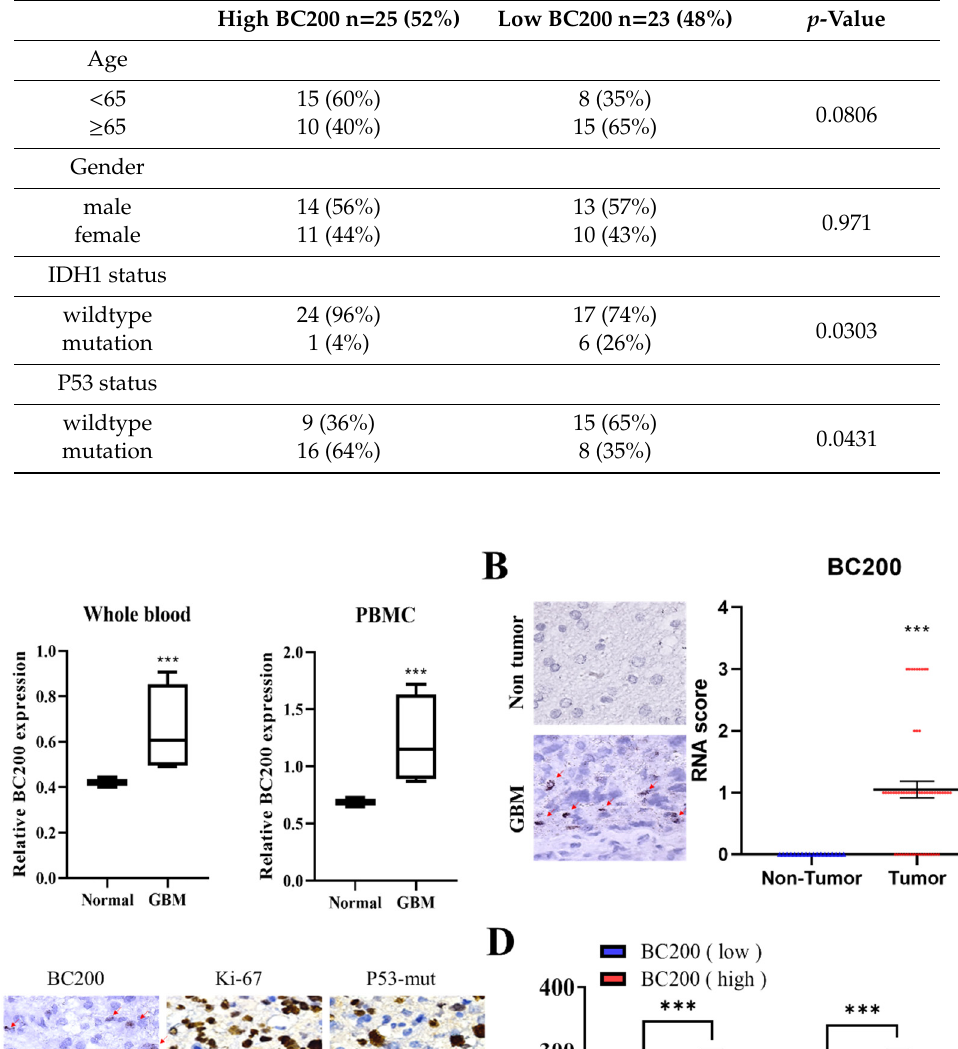
Table 1. Analysis of the association of BC200 expression with clinicopathological features of patients with primary GB ( n = 48).